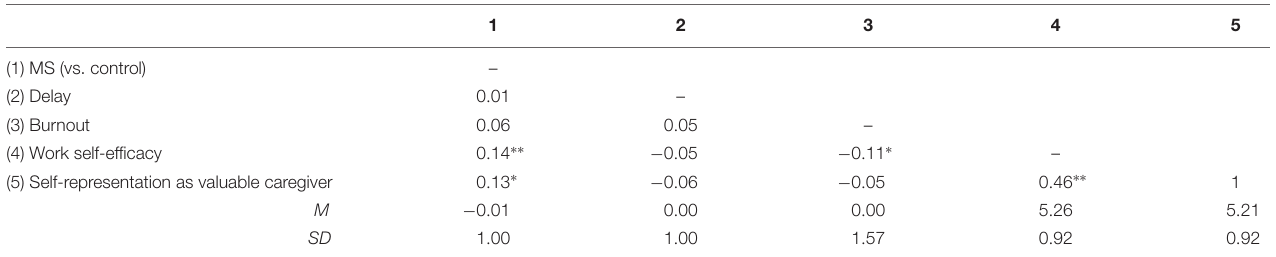
TABLE 1 | Descriptive statistics and pair-wise correlations between the variables ( N =